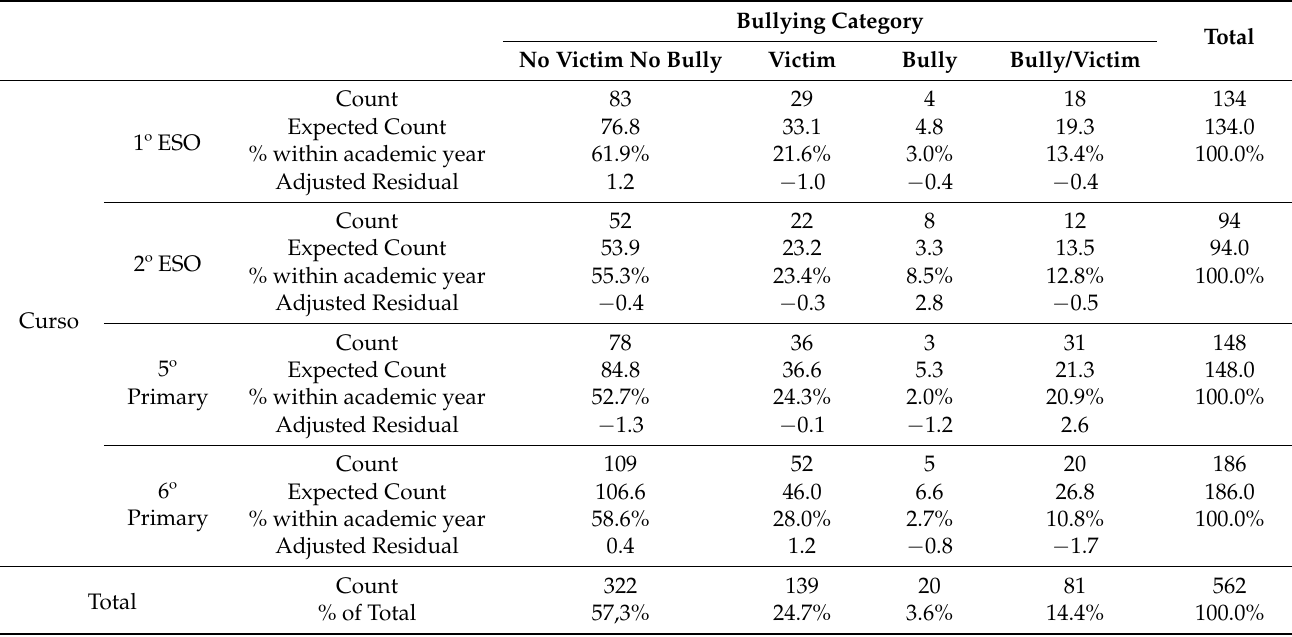
Table 2. Relationship between bullying categories and school